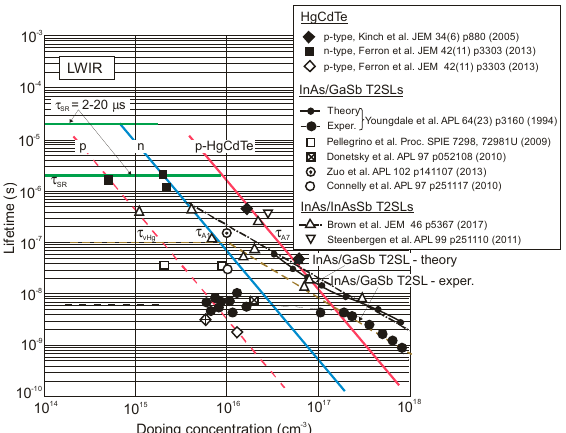
Figure 30. Minority carrier lifetimes versus doping concentration for MWIR HgCdTe and T2SLs at 77 K. Theoretical trend lines for n-type and p-type HgCdTe ternary alloys are taken from [115]. The dashed line for Ga-free T2SLs follows experimental data.